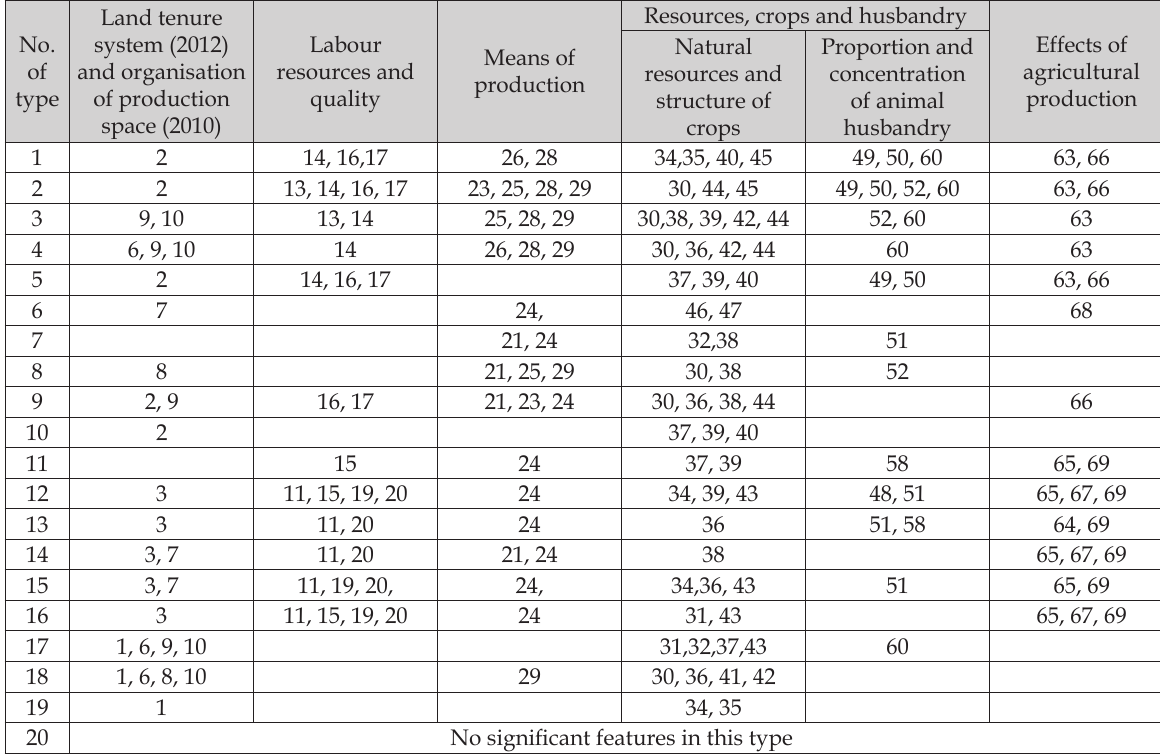
Source: own calculations on the basis of data of the 2010 National Agricultural Census, Statistics Poland and the Head Office of Geodesy and Cartography in